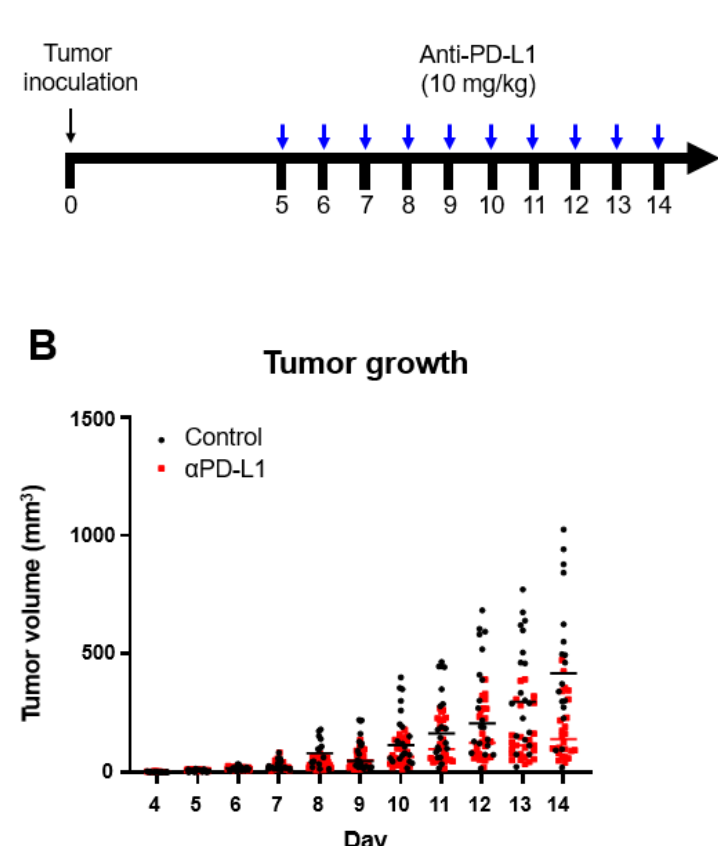
Figure 1. Anti-tumor effect of PD-L1 immunotherapy in a mouse melanoma model. ( A ) Study design. Murine melanoma B16F10 cells were inoculated into mice on day 0. Anti-PD-L1 antibody was injected daily starting from day 5 when tumor diameter was 2–3 mm. PET images were obtained at the early (days 6 and 7) and late (days 13 and 14) phases of treatment. ( B ) Tumor growth after ICI treatment in all groups.